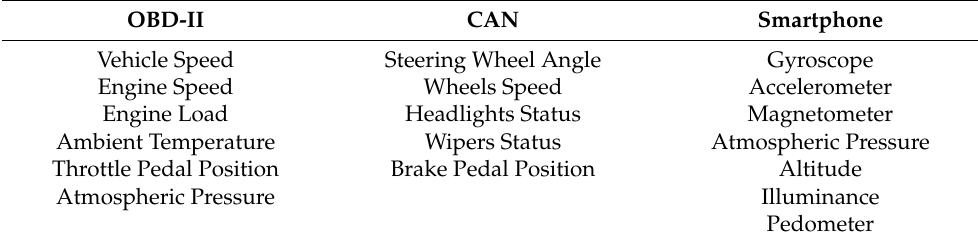
Table 3. Overview of sensors and parameters defined for data